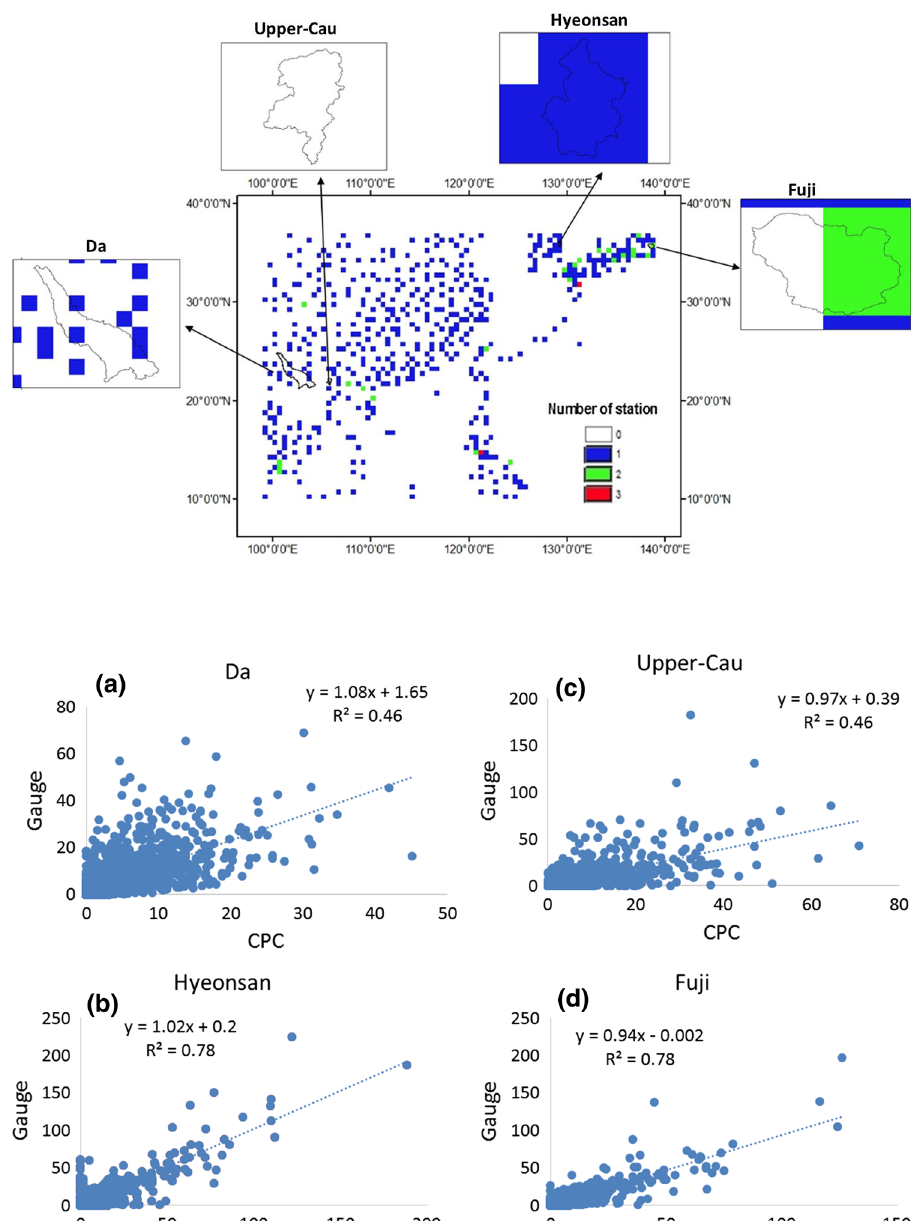
Fig. 5 Ground rain gauge distri- butions of the CPC global gauge data set in the study regions